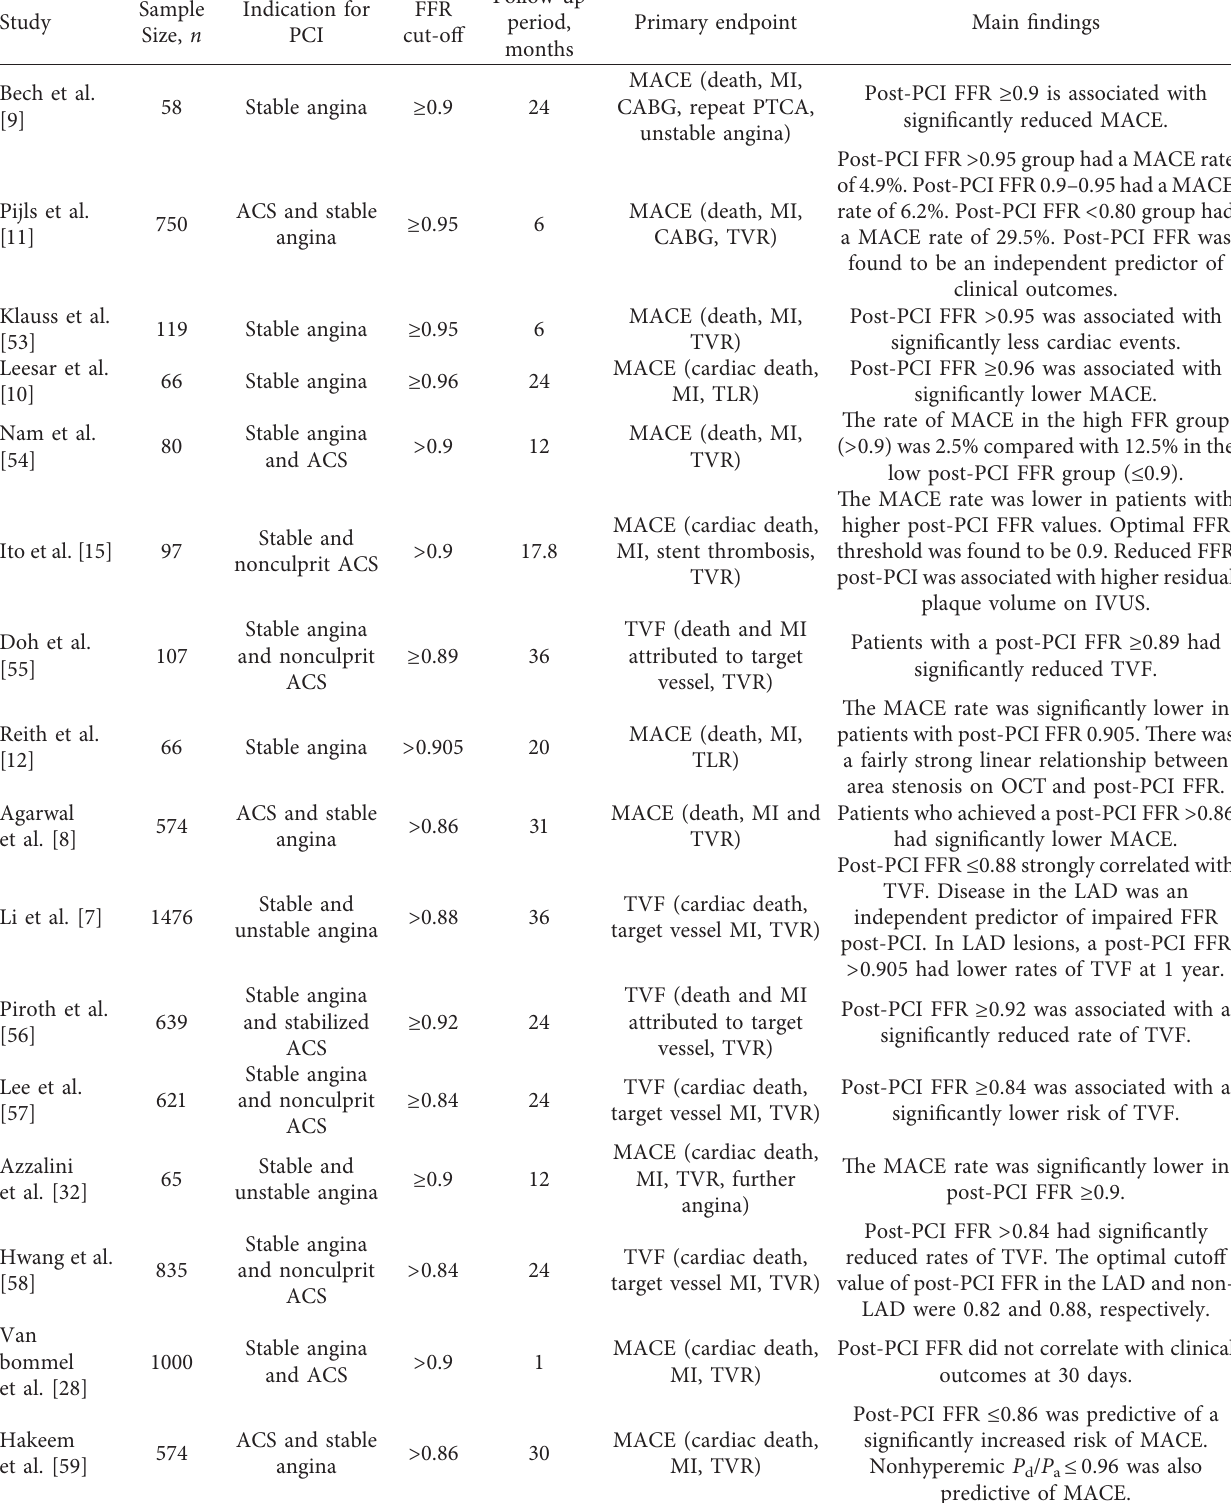
Table 1: Summary of trial data including FFR cutoffs and clinical and stent